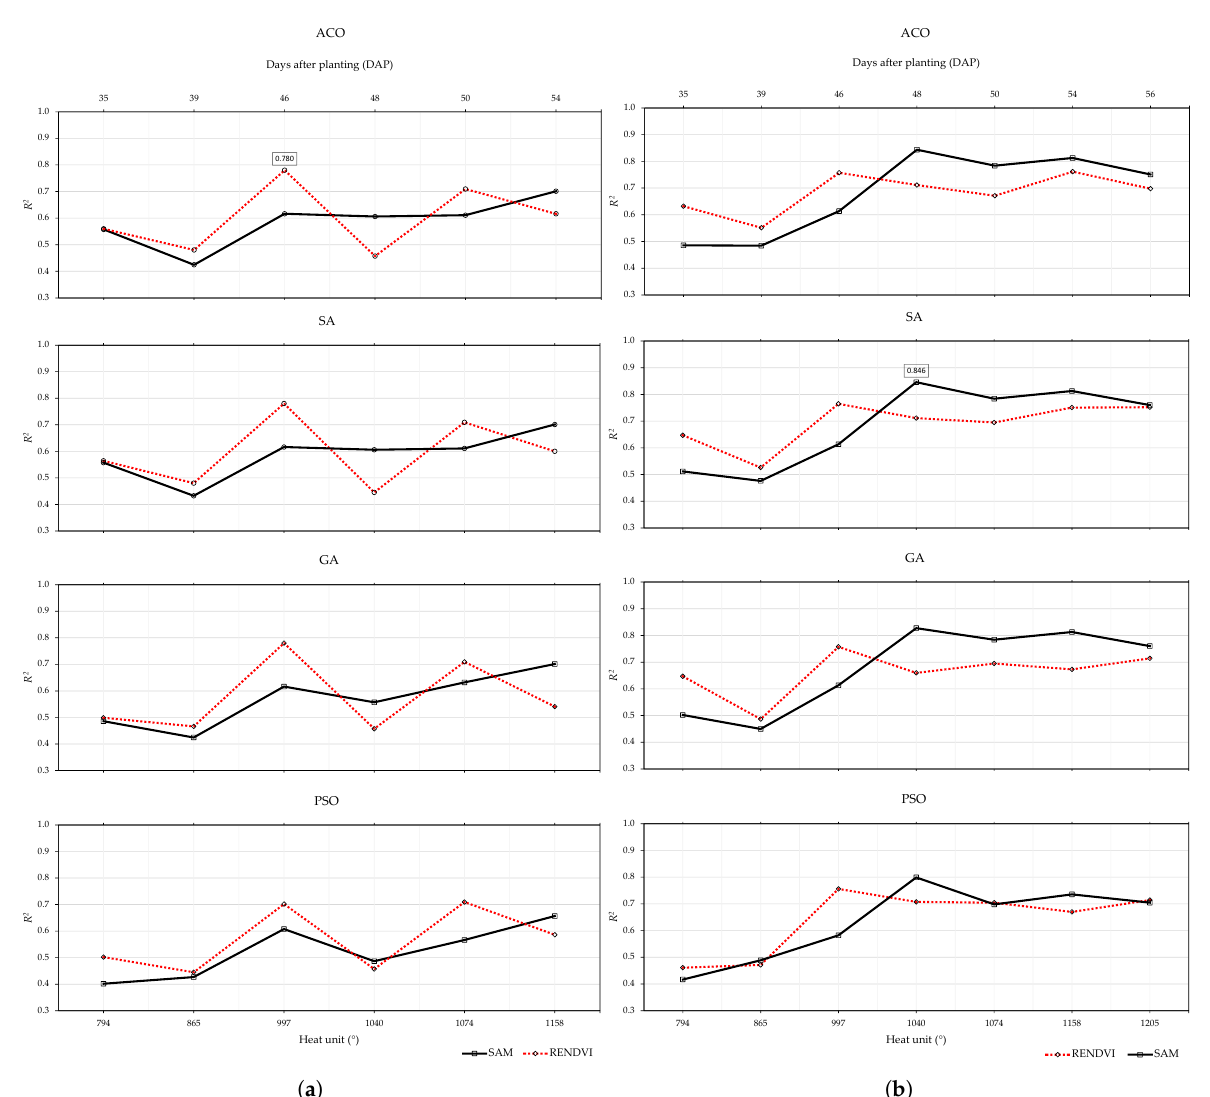
Figure 9. Results for coefficient of determination ( R 2 ) for snap bean 2019 pod weight data set, for ( a ) early and ( b ) late harvest stage, as determined via two different vegetation approaches, SAM and RENDVI, as tested on